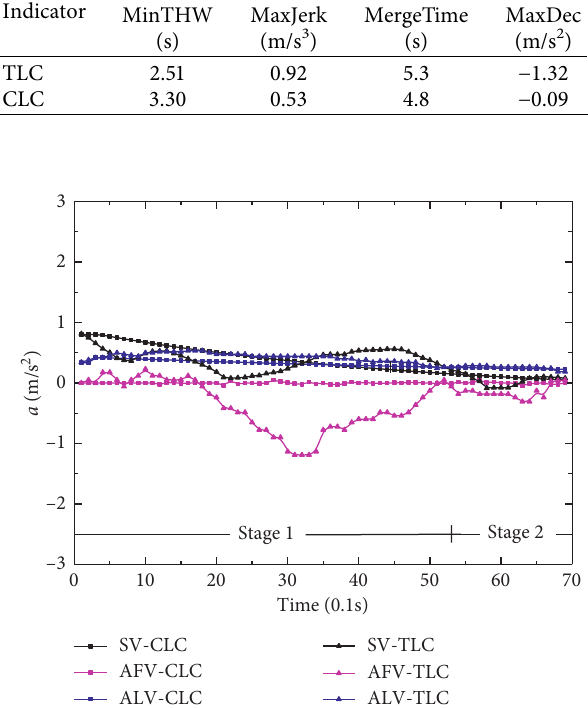
Figure 11: Vehicle accelerations during lane